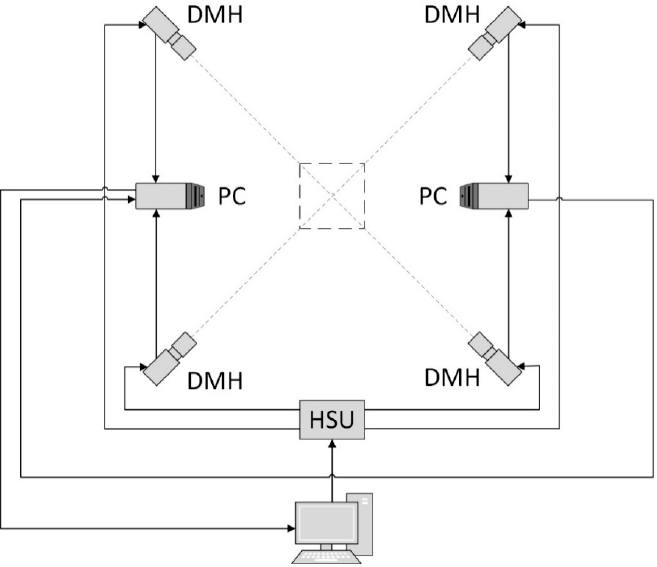
Figure 2. Communication model used in the proposed system.